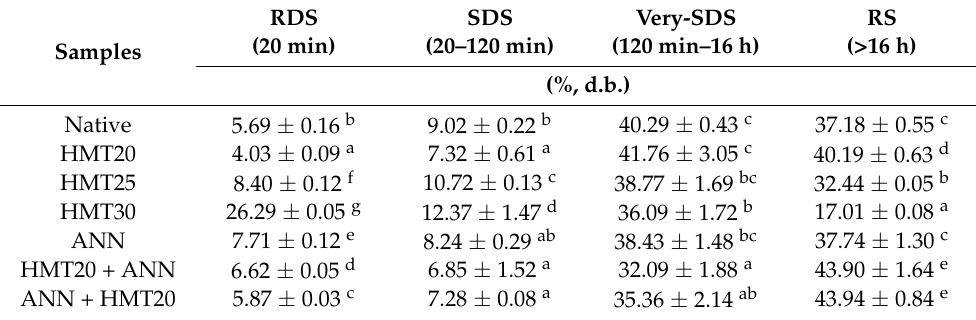
Table 2. Effect of various hydrothermal treatments on the in vitro digestibility of water caltrop starch 1,2